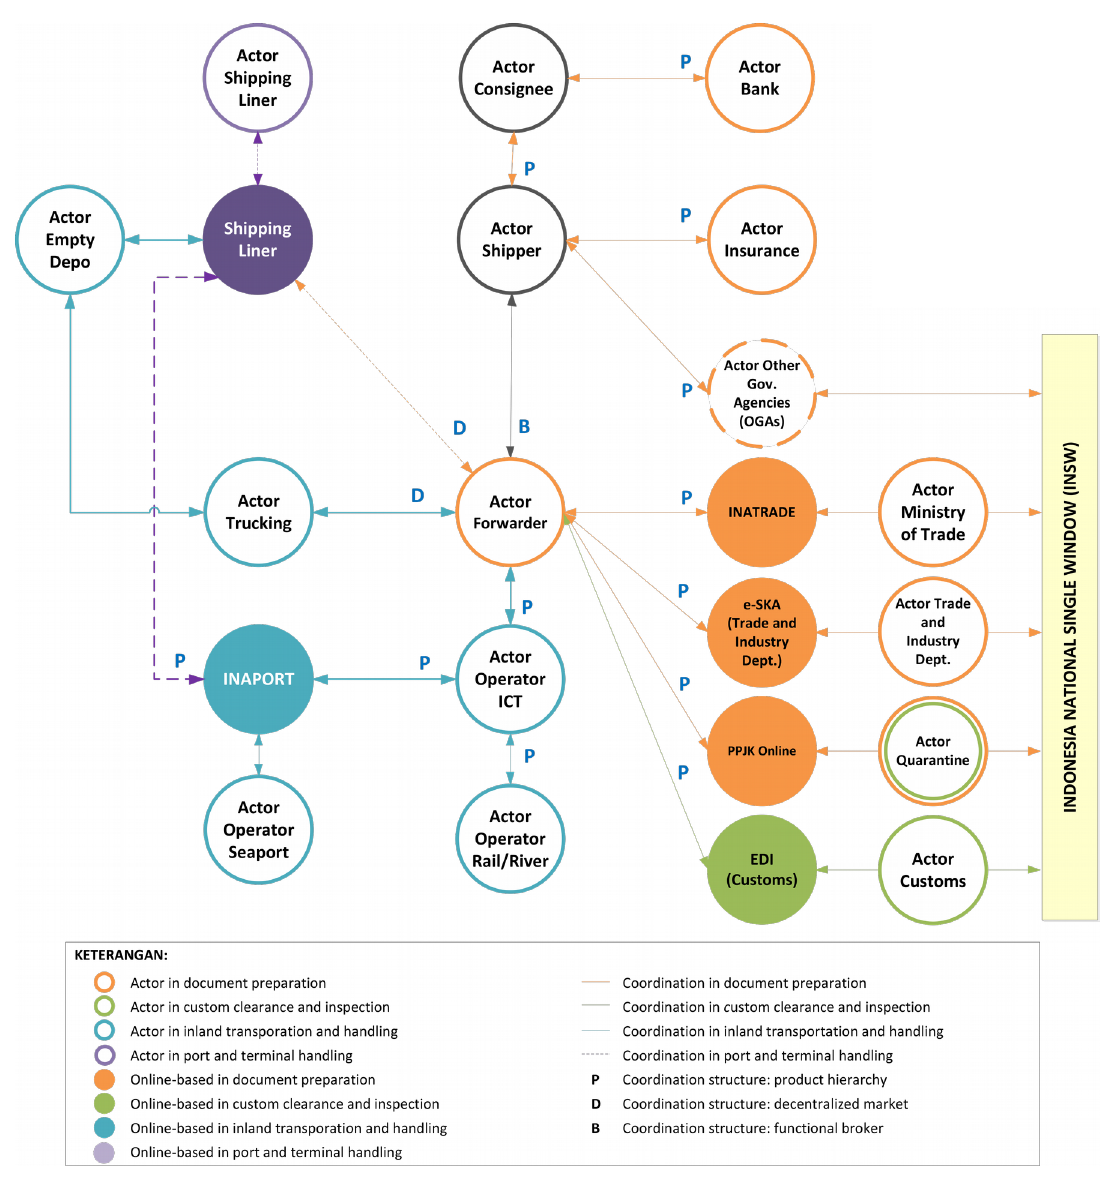
Figure 3. IOS Architecture of Existing System